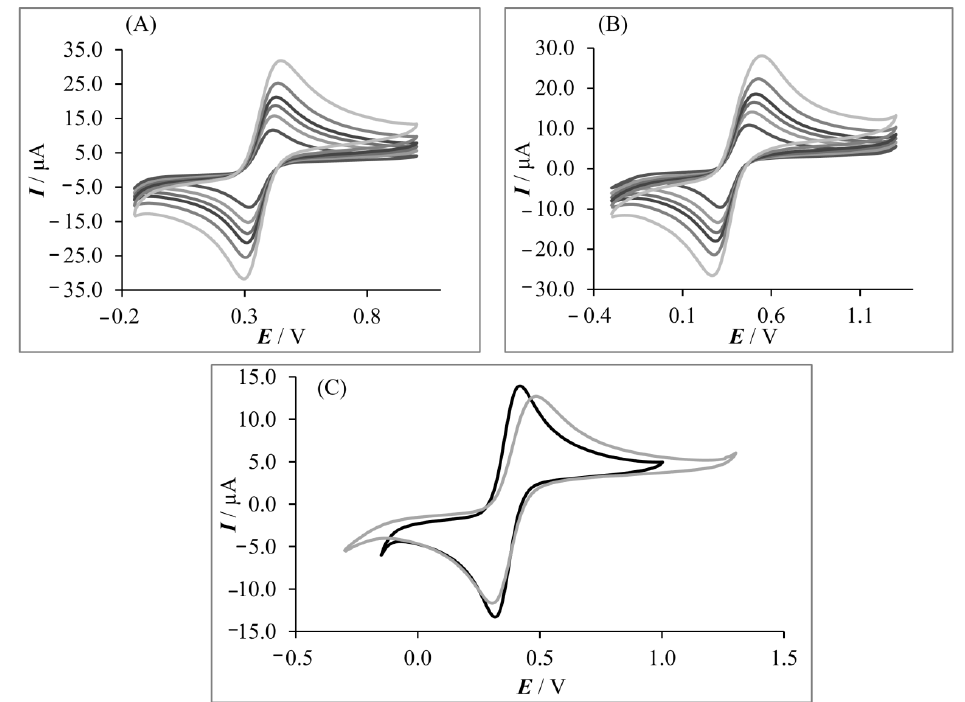
Figure 1. ( A )–( B ) Cyclic voltammograms for 1.0 mmol L −1 K 4 [Fe(CN) 6 ]/K 3 [Fe(CN) 6 ] (1:1) in Britton– (B) MLGPE; ( C ) Cyclic voltammograms for 1.0 mmol L −1 K 4 [Fe(CN) 6 ]/K 3 [Fe(CN) 6 ] (1:1) in Britton–